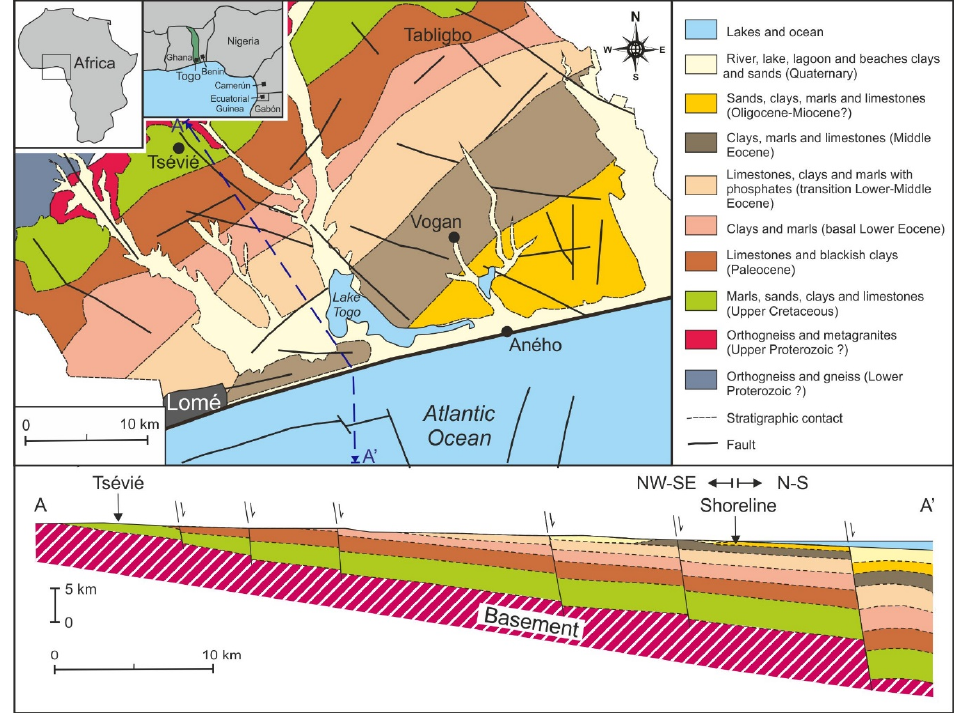
Figure 2. Geological sketch map of the Togo margin of the Atlantic Ocean, and geological cross section across onshore and offshore areas (after [23], modified). As regards the oceanographic characters of the area, different types of marine